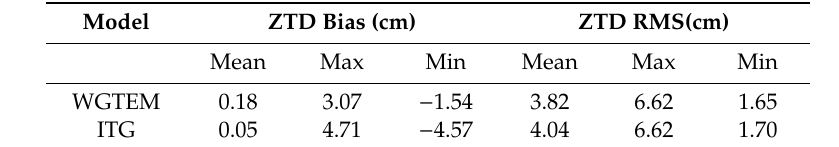
Table 5. Bias and RMS of Zenith Tropospheric Delay (ZTD) results from WGTEM and ITG models validated by IGS ZTD products.